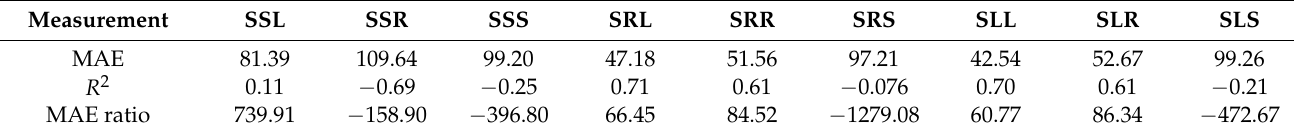
Table 6. MAE and R 2 scores of nine experimental cases for determining the regression method to TP2CME and